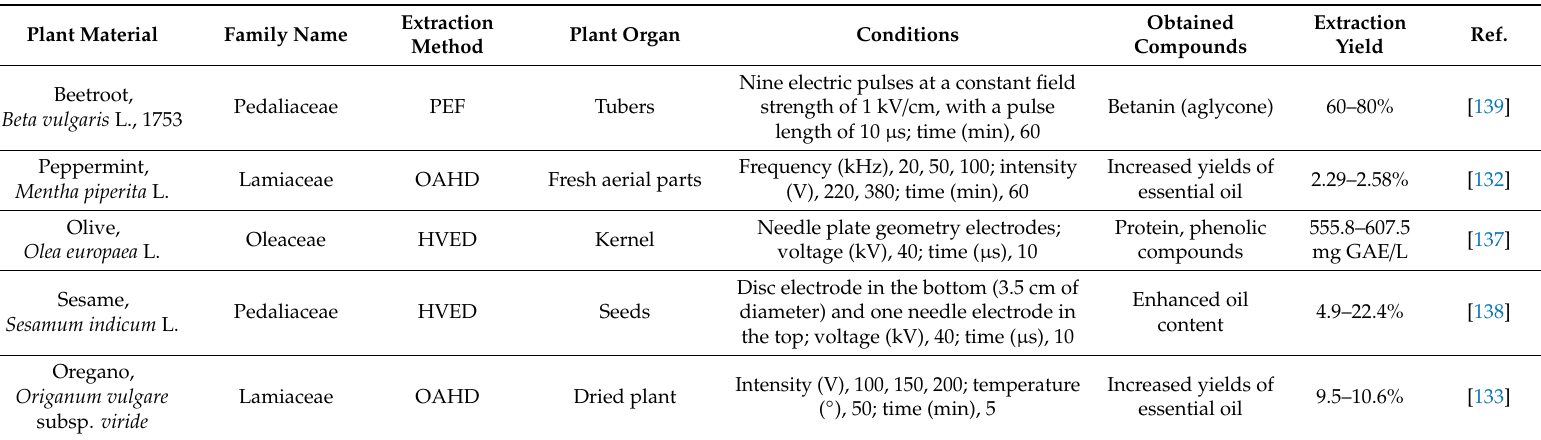
Table 5. Other extraction methods applied to di ff erent plant materials and the obtained compounds (in chronological order of the cited